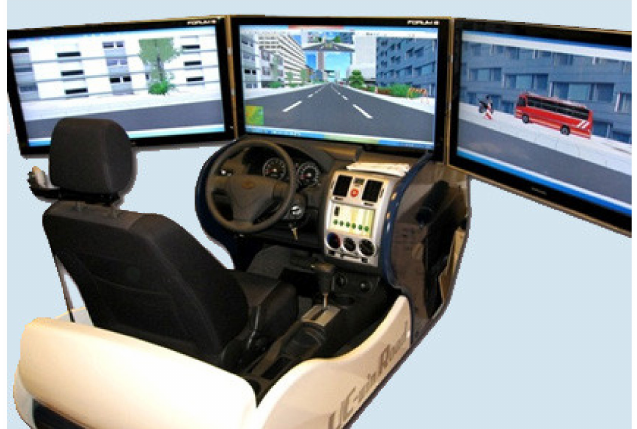
Figure 2. Driving simulator at the Safety and Behavioral Analysis (SABA) Center, Morgan State University.